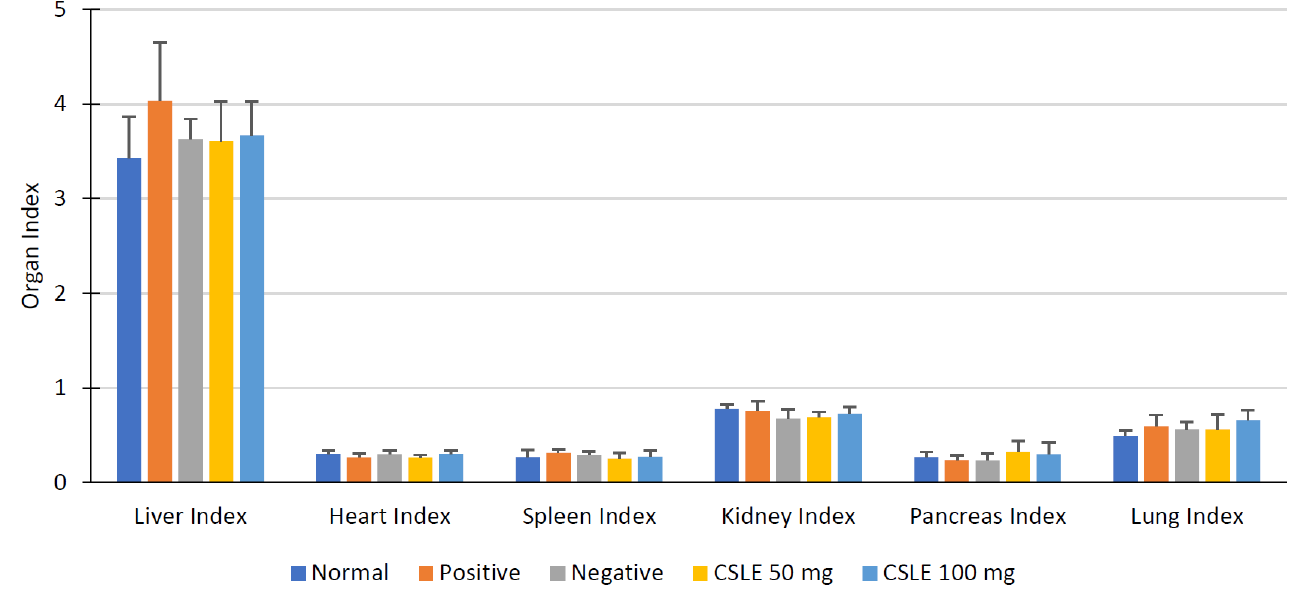
Figure 5. Organ index diagram. 220